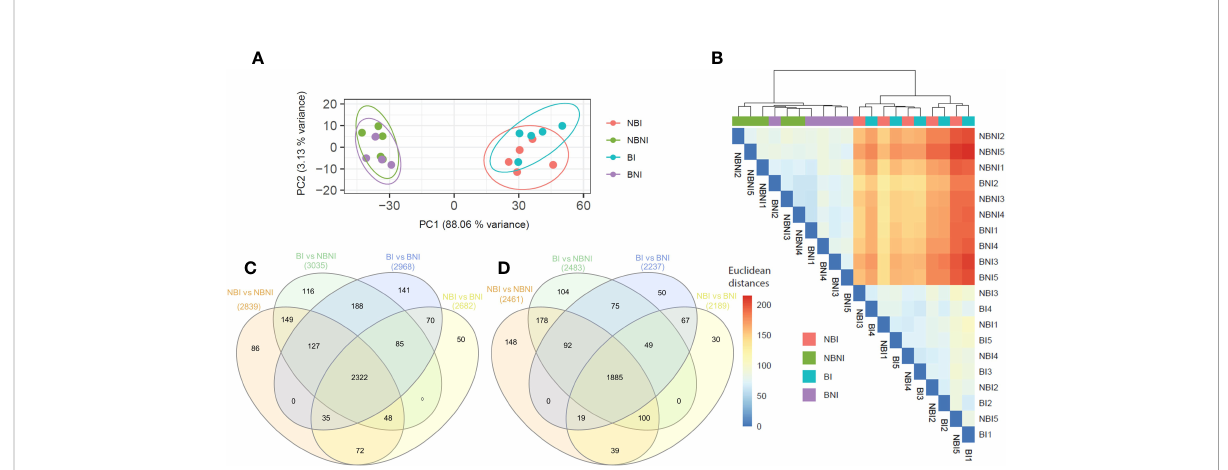
FIGURE 3 Co-expressed and unique Fragaria vesca transcripts after b -aminobutyric acid (BABA) treatment and Botrytis cinerea infection. (A) Principal component analysis (PCA) analyses of samples based on RNA-Seq data (con fi dence ellipses with 95% con fi dence interval). (B) Euclidean distances between samples. Analyses were performed using the R package pcaExplorer (version 2.22.0). (C, D) Venn diagrams of co-expressed and uniquely expressed genes (Log2 > 1) after pairwise comparison of different treatments: (C) downregulated and (D) upregulated differentially expressed genes. Treatment combinations: B. cinerea -infected (NBI; No-BABA and Infected), mock-infected (NBNI; No-BABA and Non- Infected), BABA-treated and B. cinerea -infected (BI; BABA and Infected), and BABA-treated and mock-infected (BNI; BABA and Non-Infected).